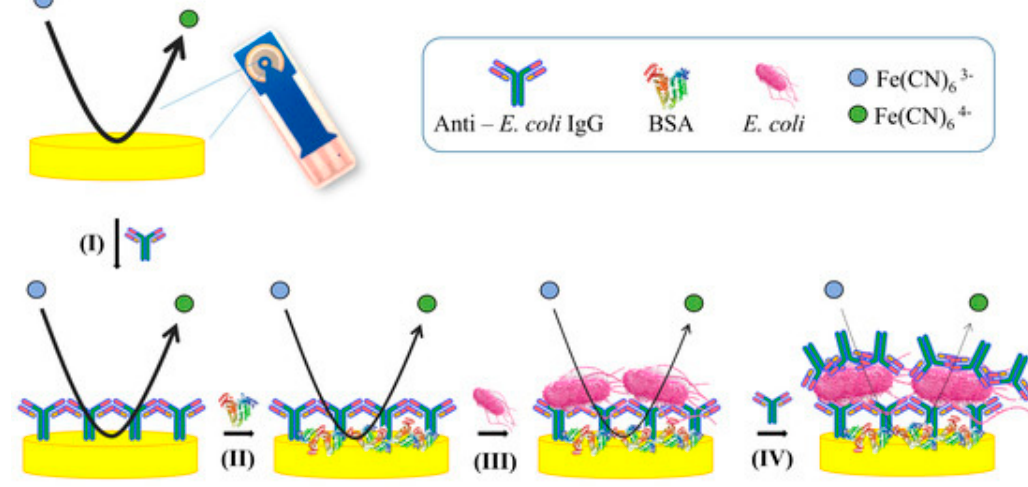
Figure 4. Schematic illustration of the stepwise functionalization and detection of the proposed immunosensor. The black line shows the redox reaction intensity, which is inhibited as the surface covering grows. Its thickness reduction is related to decrease of the “effective” area available for the electrolyte current, which is measured through an increase of the charge transfer resistance. (I: functionalization of the surface with antibodies, II: blocking the free remaining spaces on the gold electrode by BSA, III: reaction of immobilized antibodies and the E. coli cells, IV: conveying a fresh anti-E. coli Abs solution to the circuit) [73] .